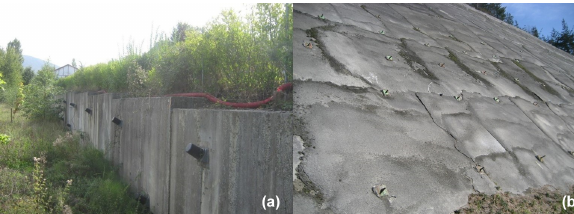
Figure 7. (a) PoR L1C of the road GI-3324 (from km 0.700 to 1.450) without protection measures; (b) PoR P4C of the road N- 1 (km 407.395 to 407.680) with protection measures.